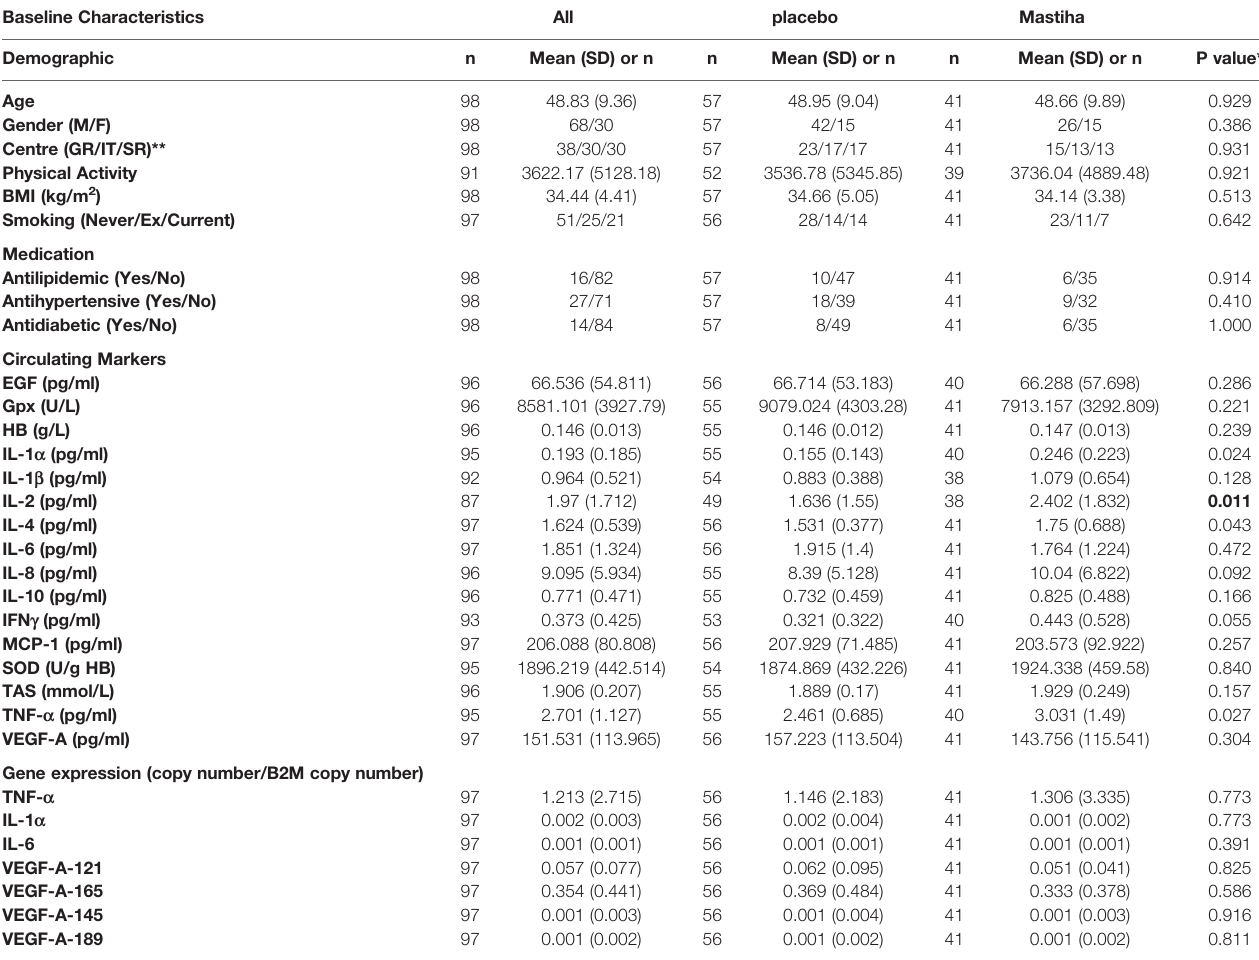
TABLE 1 | Baseline characteristics of all participants and per trial group. Baseline